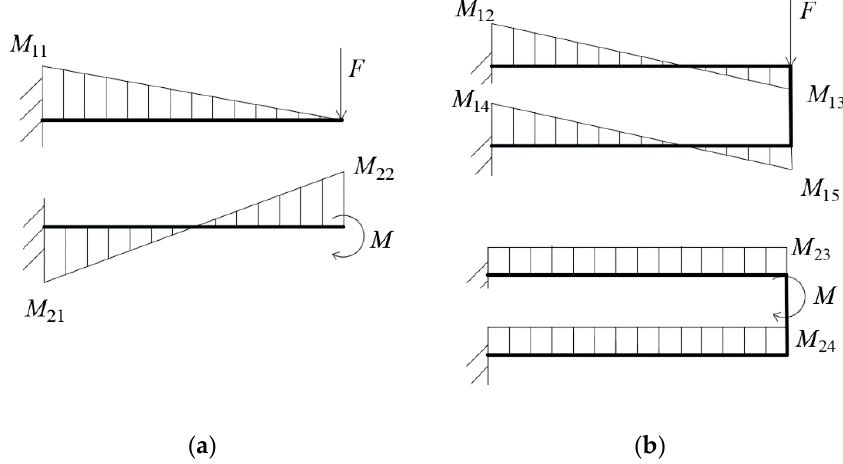
Figure 9. ( a ) Moment diagram of single beam. ( b ) Moment diagram of parallel beam.